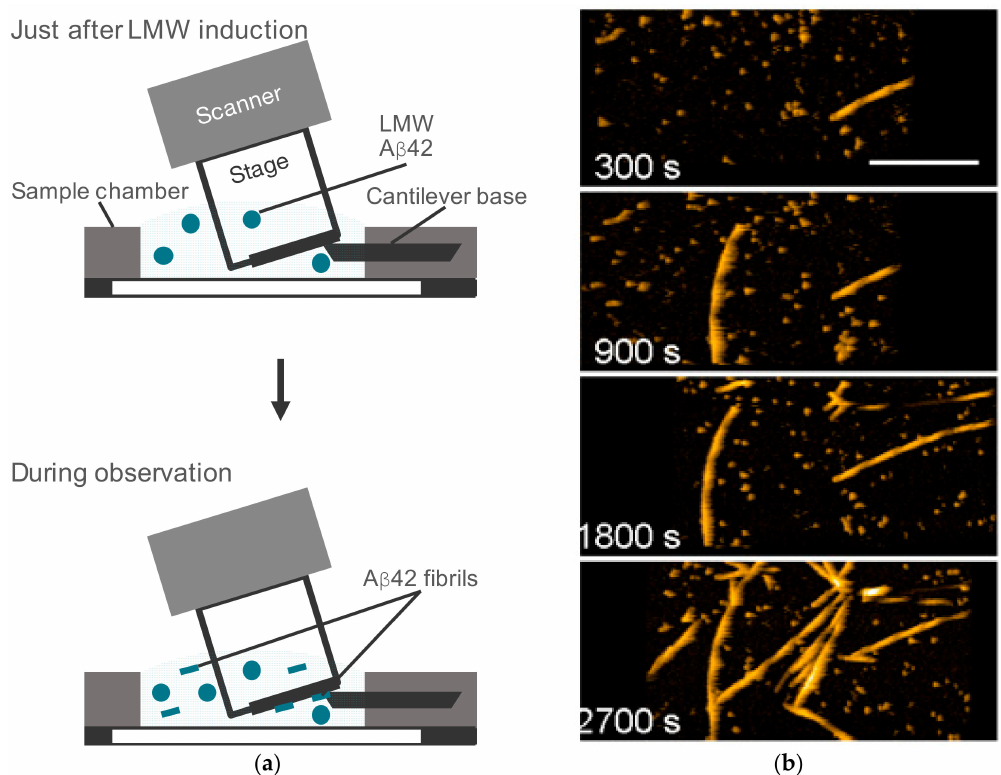
Figure 1. High-speed atomic force microscopy (HS-AFM) observation of amyloid- β (A β )42 fibril elongation. ( a ) Schematic view of HS-AFM observation of low molecular weight (LMW) A β 42 incubation. LMW A β 42 in 10 mM sodium phosphate, at pH 7.4, was introduced with 0.1 M NaCl for aggregation acceleration. Some aggregates in the solution bound to the mica surface and the fibrous aggregates in them were elongated by the incorporation of the LMW A β 42 in free solution. ( b ) Representative HS-AFM images of LMW A β 42 incubation at the indicated time after addition of 0.1 M NaCl. The scale bar is 300 nm. Reproduced from